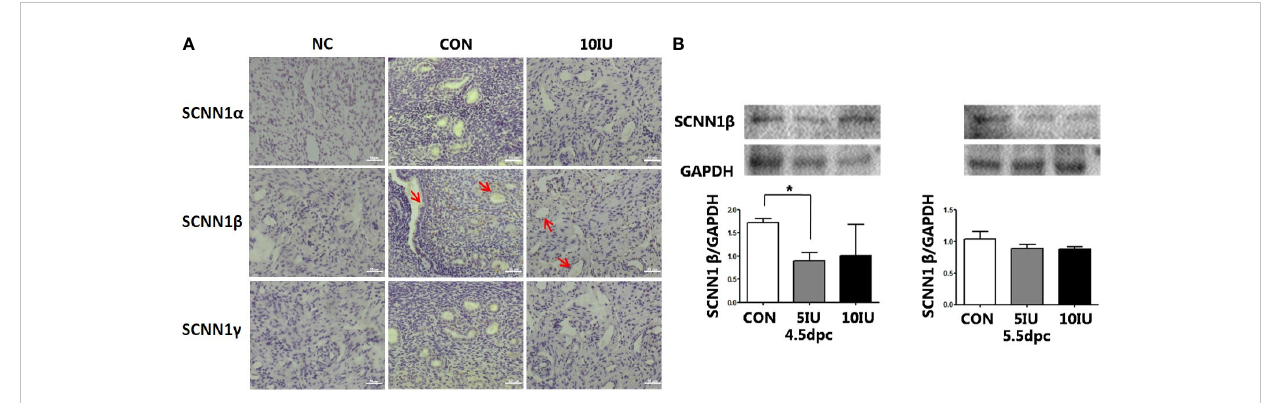
FIGURE 9 Localization and protein expression of the sodium channel proteins SCNN1 a , SCNN1 b and SCNN1 g in the mouse endometrium at 4.5 dpc and 5.5 dpc among the CON, 5 IU and 10 IU groups. (A) Localization of SCNN1 a , SCNN1 b and SCNN1 g in the endometria of mice in the CON and 10 IU groups at 5.5 dpc. Bar=50 m m. (B) Protein expression of SCNN1 b in the endometria of mice in the CON, 5 IU and 10 IU groups at 4.5 dpc and 5.5 dpc. NC: negative control. Compared with the CON group, *p<0.05. The arrows indicate the localization of target